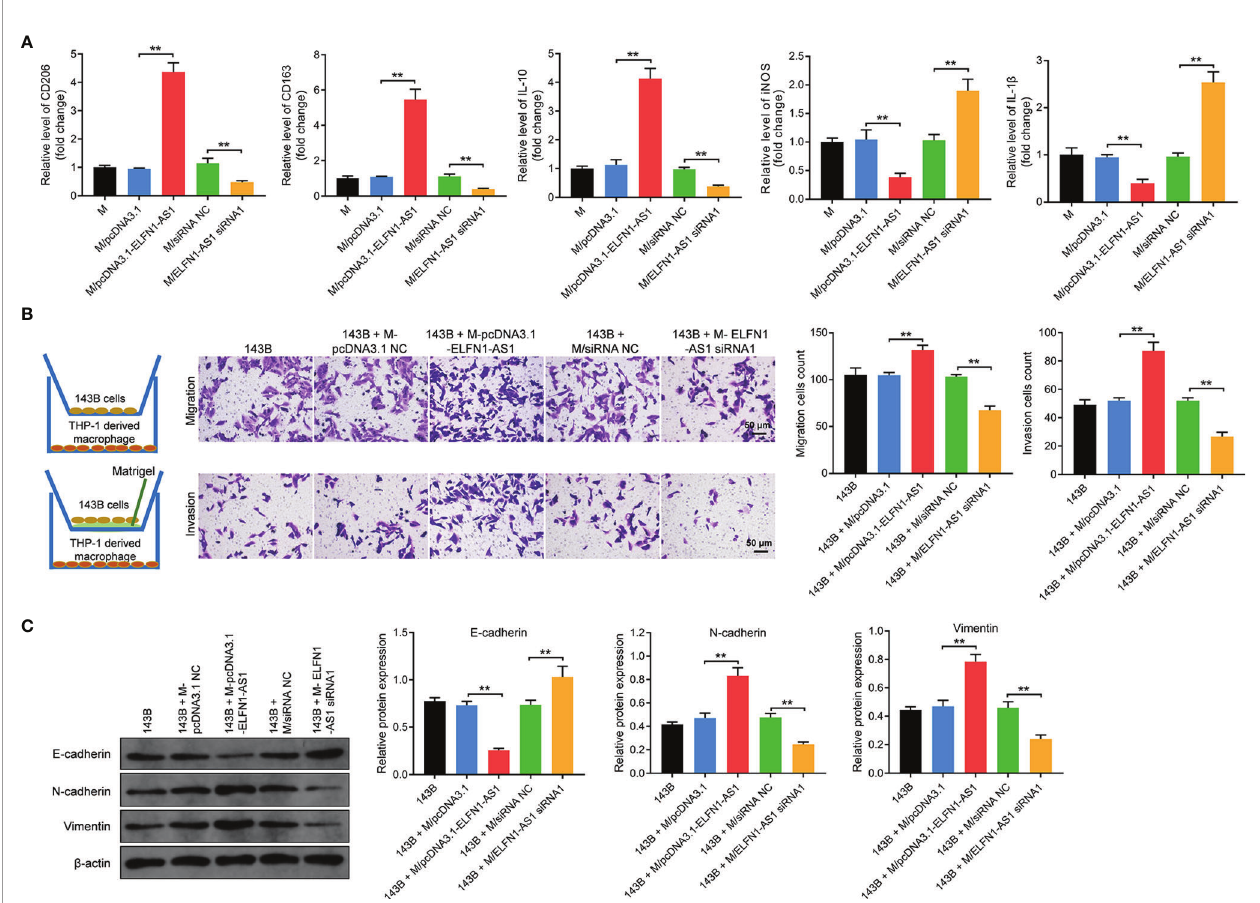
FIGURE 5 | Exosomes with upregulated ELFN1-AS1 promoted migration and invasion in OS cells via inducing macrophages M2 polarization in vitro . (A) Macrophages were transfected with pcDNA3.1 ELFN1-AS1 or ELFN1-AS1 siRNA1; RT-qPCR analysis of CD206, CD163, IL-10, iNOS, IL-1 b level (n = 3). (B) 143B cells (upper chamber) were co-cultured with transfected macrophages (lower chamber). Transwell migration and invasion assays were applied to determine cell migration and invasion (n = 3). (C) Western blot analysis of E-cadherin, N-cadherin and vimentin in 143B cells (n = 3). The signi fi cance between groups was analyzed by one-way ANOVA. **P <